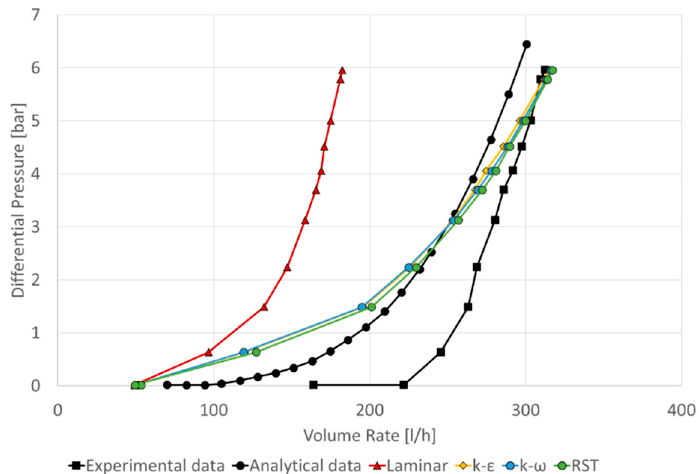
Figure 17. The model results for one laminar and three turbulence models based on RANS formulation (k- ε , k- ω , and RST) contrasted with the experimental and analytical data.